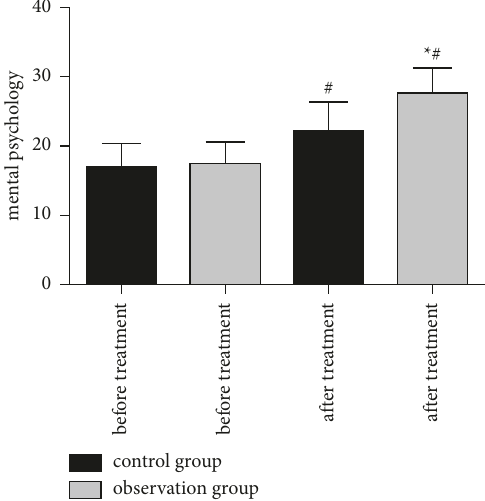
Figure 9: Physical function scores of two groups of patients at different times. Compared with the same group before treatment, # ∗ P < 0 . 05; compared with the control group, ∗ P < 0 .